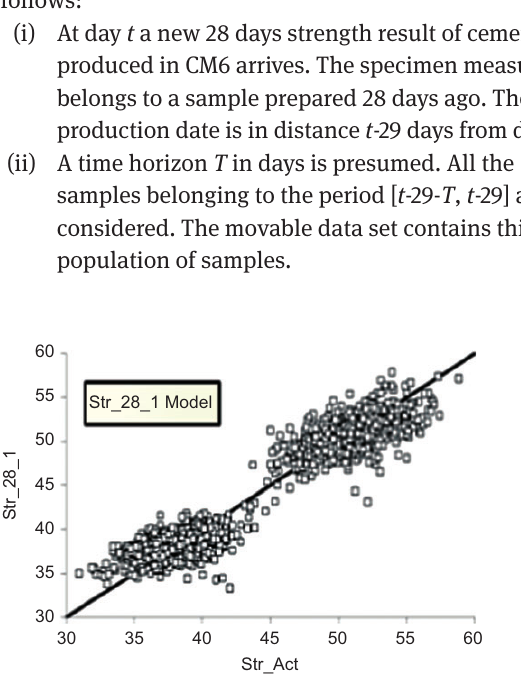
Figure 6 Coefficients of % Clinker and Str_1 for the first